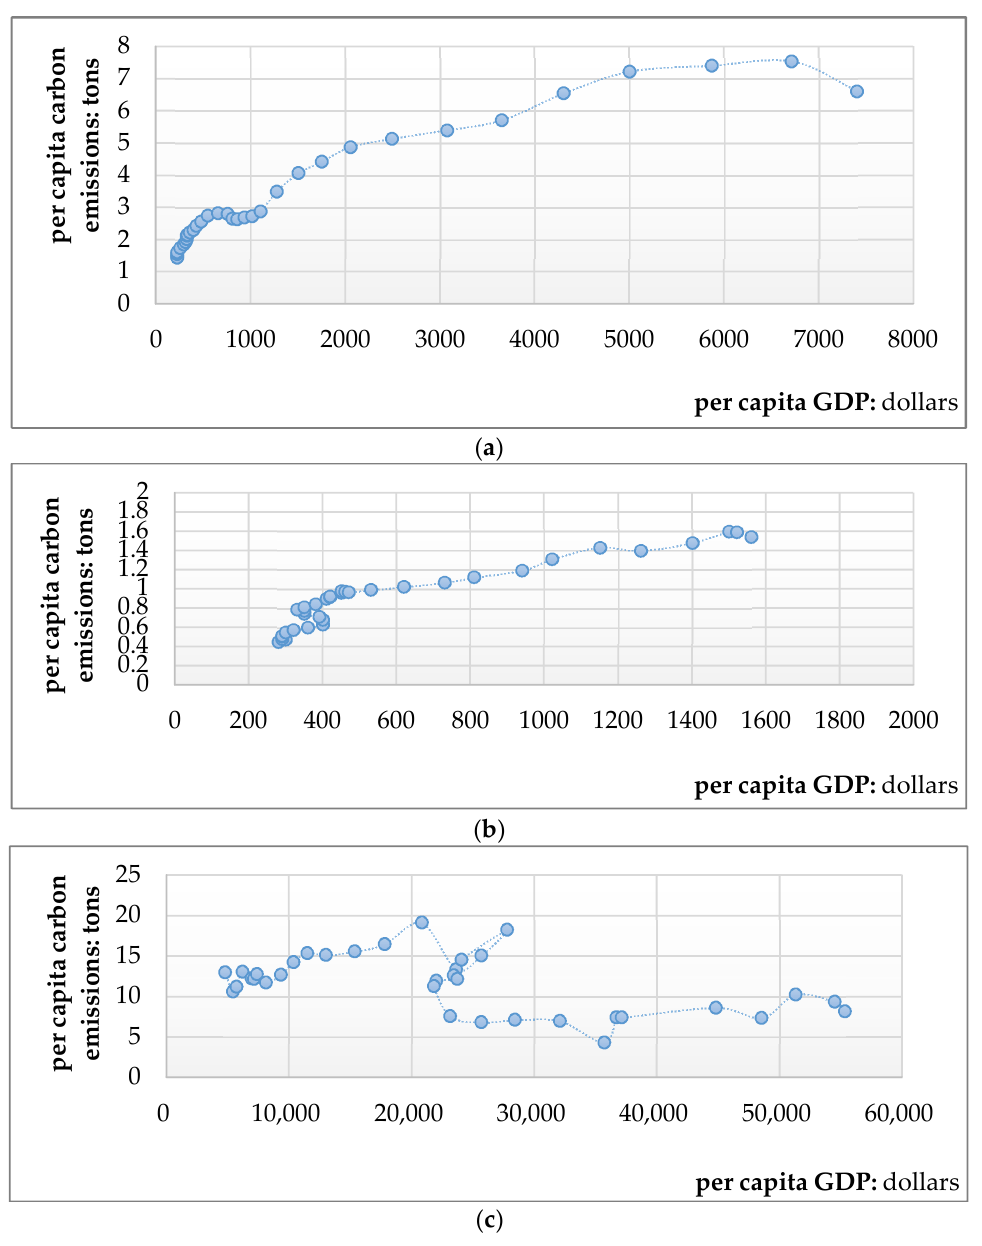
Figure 6. The relationships between per capita emissions and per capita GDP in three typical B&R countries. ( a ) is the relationship in Singapore; ( b ) represents that in China and ( c ) is that in India.